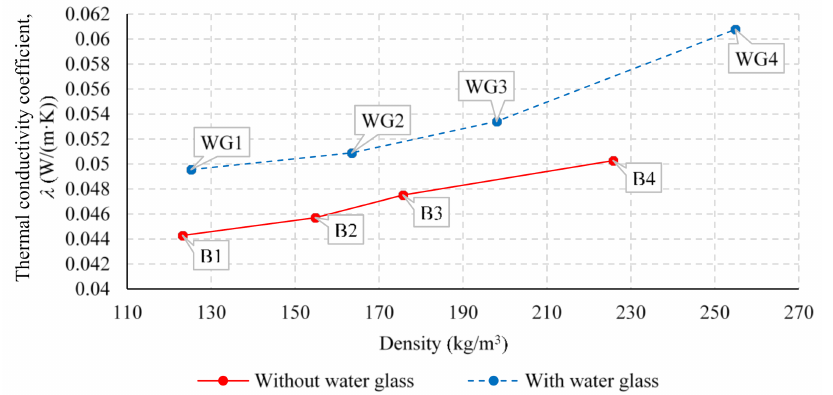
Figure 7. Relationship between thermal conductivity coefficient λ and density of the produced ther- mal insulation boards for specimens with a thickness of 30 mm with and without added water